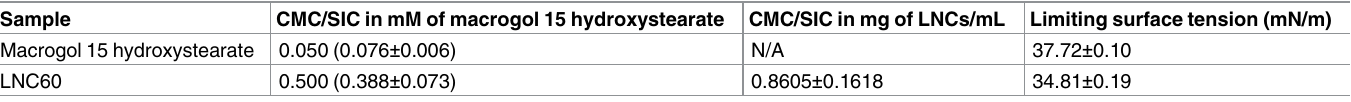
Table 2. Critical micellar concentration (CMC), saturated interfacial concentration (SIC) and the limiting surface tension of the MHS solution and LNC dispersion as determined by drop tensiometry. The CMC/SIC is the concentration at which a sharp changein the slope has occurred. The concen- trations (given in brackets) correspondto the calculatedCMC/SIC based on the slope of the surface tensionisotherms. The limiting surface tension is the low- est surface tensionobservedfor a given system regardlessof the bulk concentration.